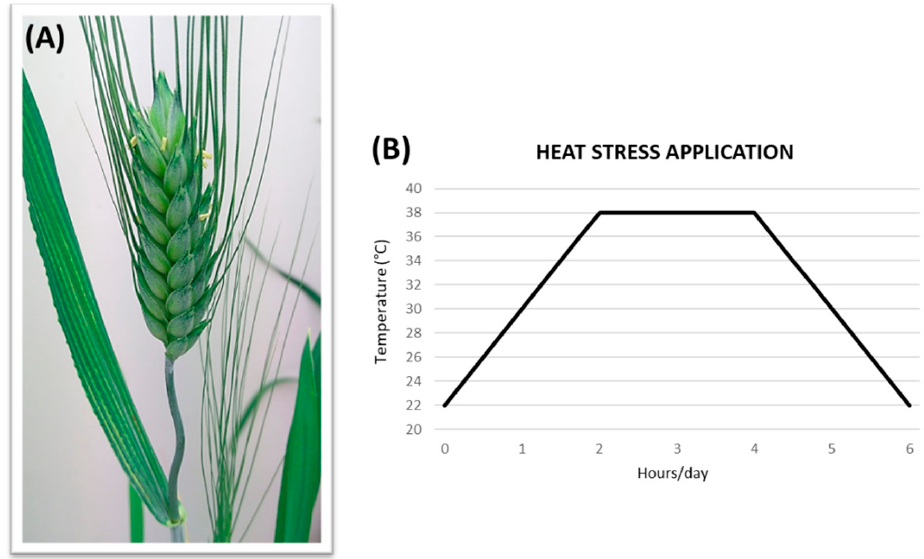
Figure 2. Heat stress application: ( A ) Phenological phase of the main tiller at the time of stress ap- plication, corresponding to anthesis (Zadoks scale 61–65). ( B ) Procedure followed for heat treat- ment, performed for three consecutive days in the heat stress experiment, and for three or seven consecutive days in the combined heat + water-deficit stress experiments.